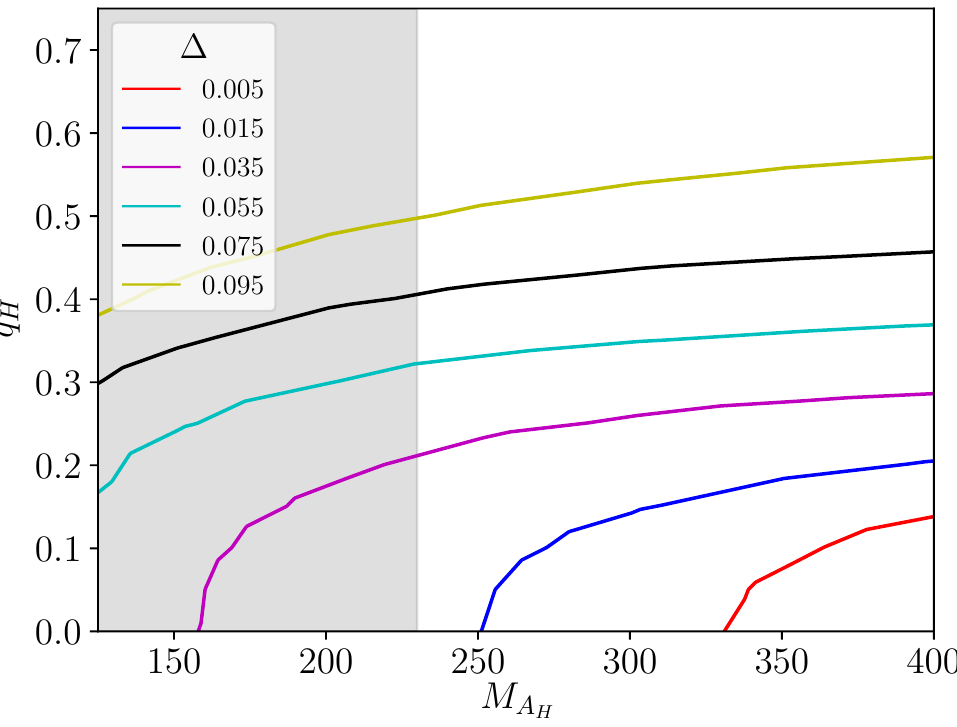
Figure 19 . Contours of Ω h 2 = 0 . 12 for fixed values of ∆ for c A gives too large DM density and is excluded. The shaded region is excluded from direct detection experiments. See text for